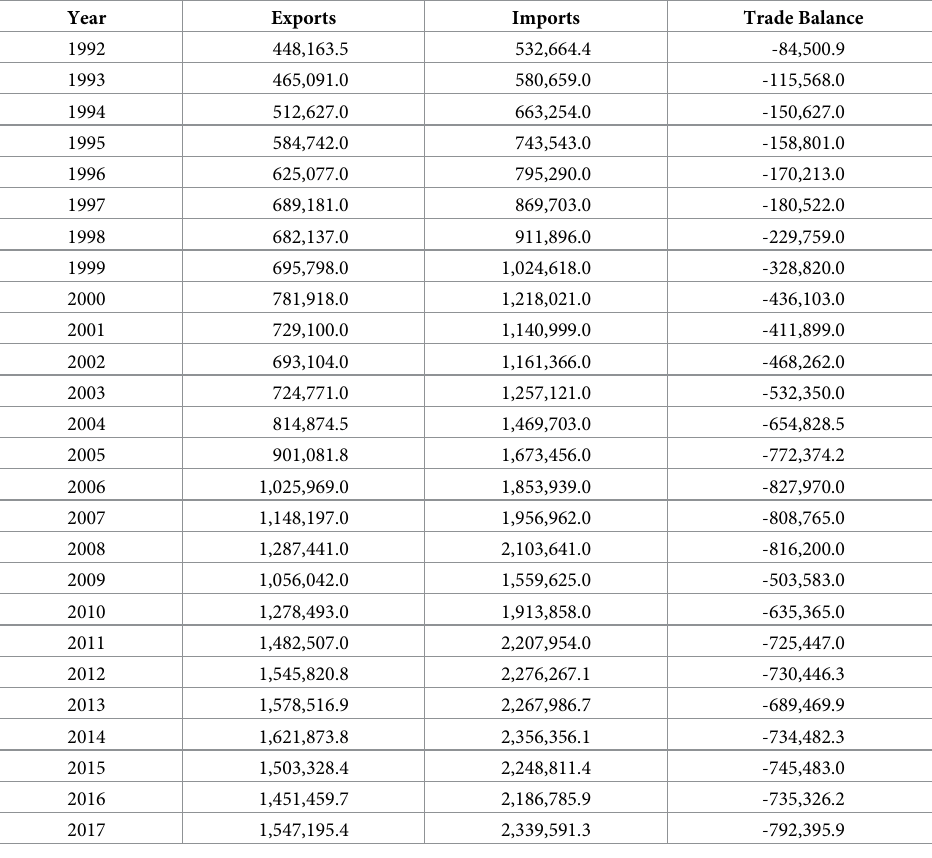
Table 2. U.S. total trade for goods for 1992–2017 (seasonally